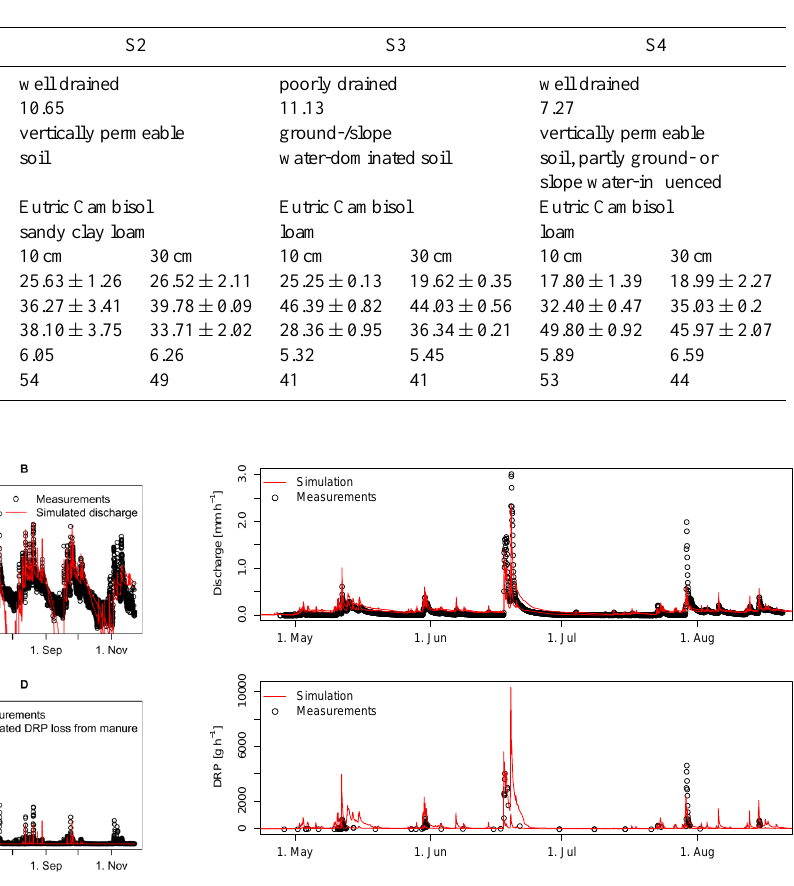
Table 3. Site characteristics of the four permanent measurement stations in the Stägbach catchment.